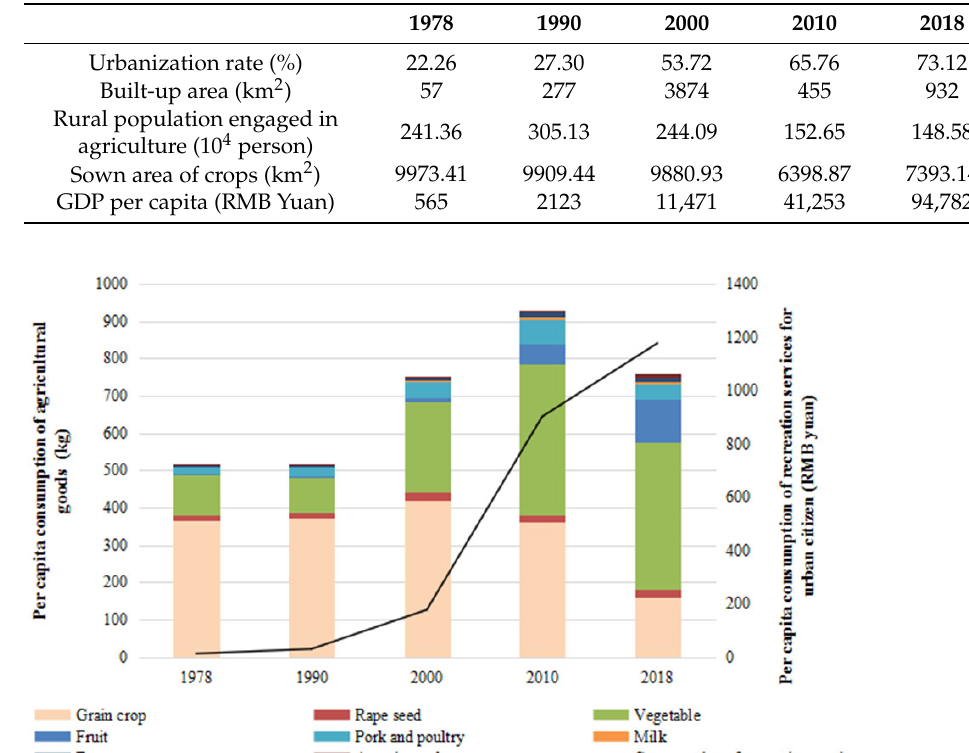
Figure 5. Consumption of agricultural goods and services per capita from 1978 to 2018 in Chengdu metropolitan area.